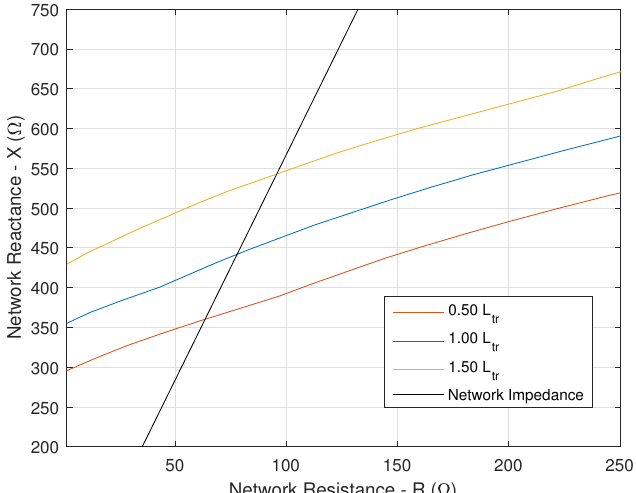
Figure 13. Stability limit curve of a traction chain in the network reactance ( X ) and resistance ( R ) complex plane. Variation of leakage